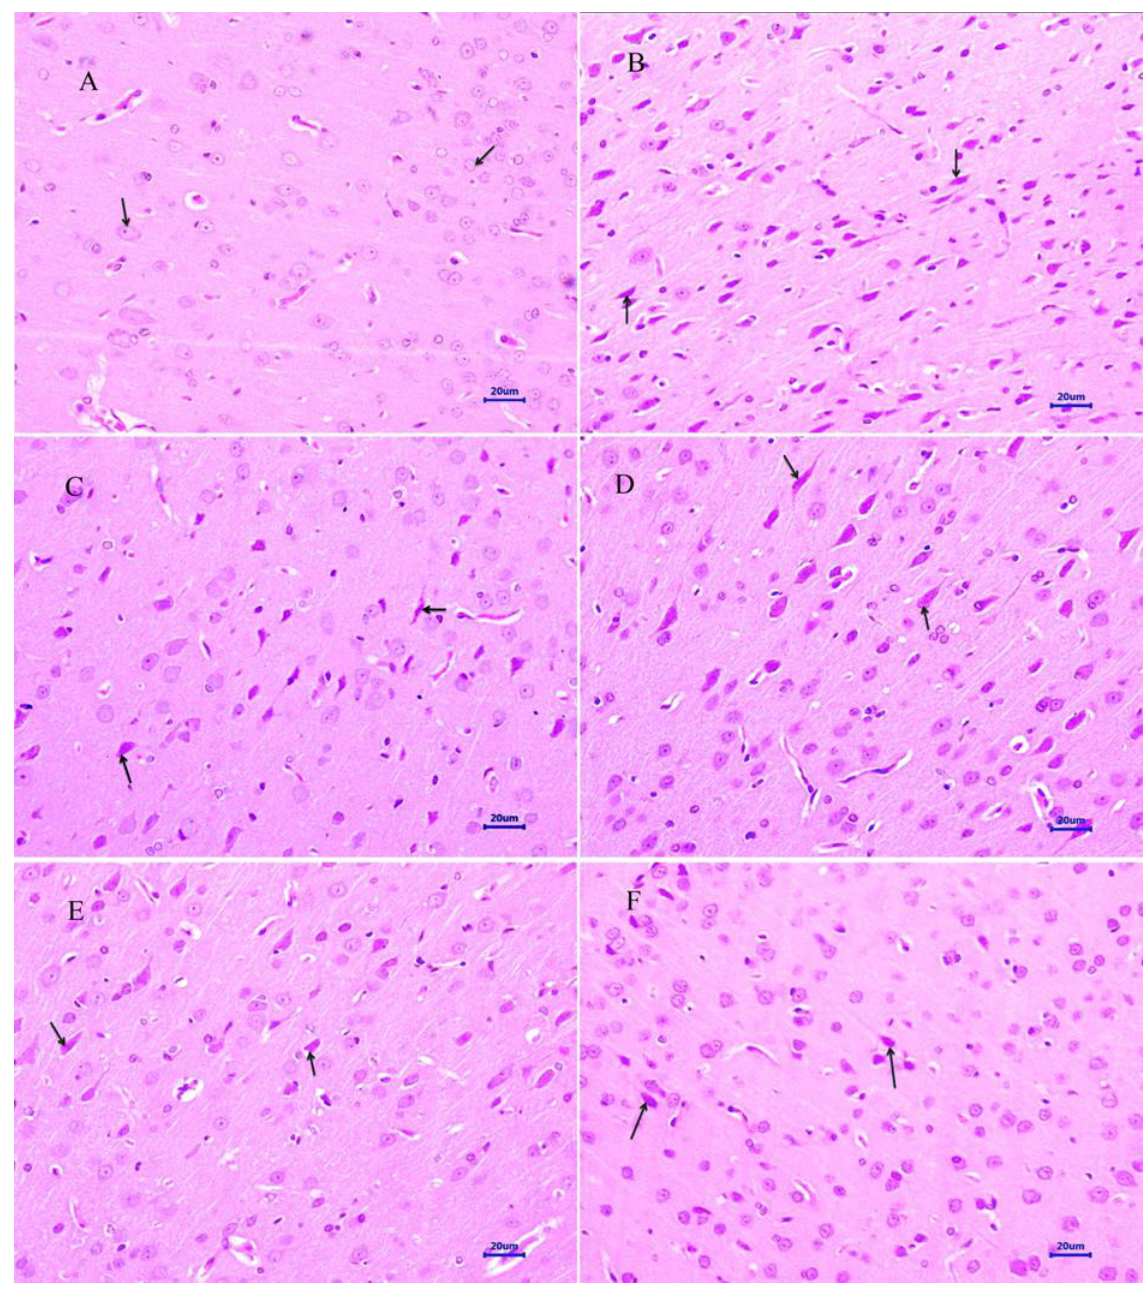
Figure 7. Effect of quercetin and quercetin administered with memantine on H&E-stained cortex tissue (400×). ( A ): Normal control, ( B ): Disease control, ( C ): Memantine (20 mg/kg), ( D ): Quercetin (50 mg/kg), ( E ): Memantine + quercetin (20 + 25 mg/kg), ( F ): Memantine + quercetin (20 + 50 mg/kg). The immunoreactivity was evaluated based on the percentage of positive neuronal cells, distribution of observed tissue section, and intensity of staining and was graded as No reactivity, minimal, mild, moderate, marked/moderately severe, and